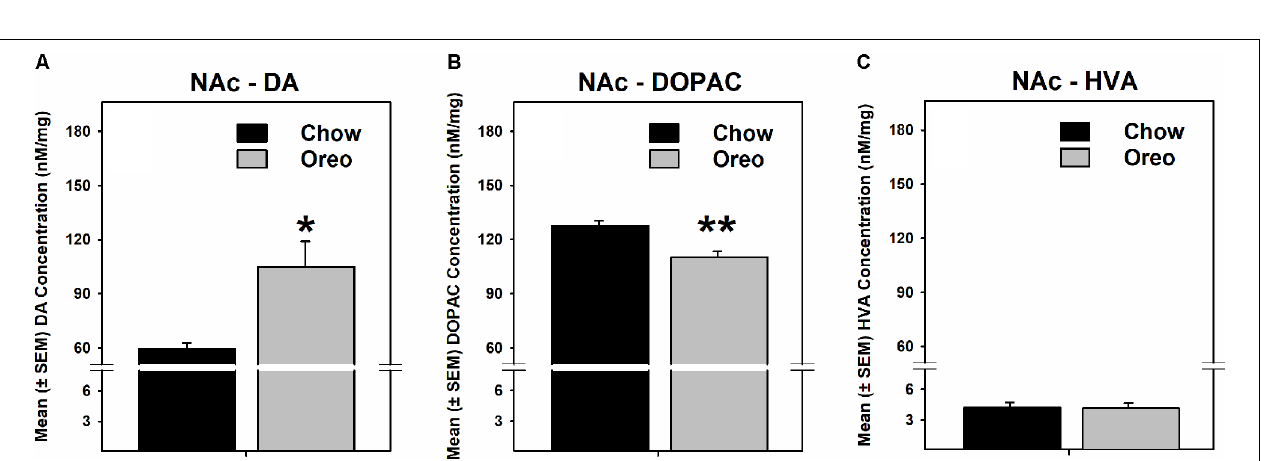
FIGURE 7 | Effect of patterned feeding of HPF on dopamine levels in the NAc. Data represent mean ( ± SEM) concentrations (nM/mg of tissue wt) of (A) DA, (B) DOPAC and (C) HVA in the nucleus accumbens (NAc). DA levels were significantly elevated, whereas DOPAC levels were significantly reduced in the NAc of the Oreo group of rats compared to the chow controls. HVA levels were not significantly different between groups. * p < 0.05, ** p < 0.01 compared to chow. DA, dopamine; DOPAC, 3,4-Dihydroxyphenylacetic